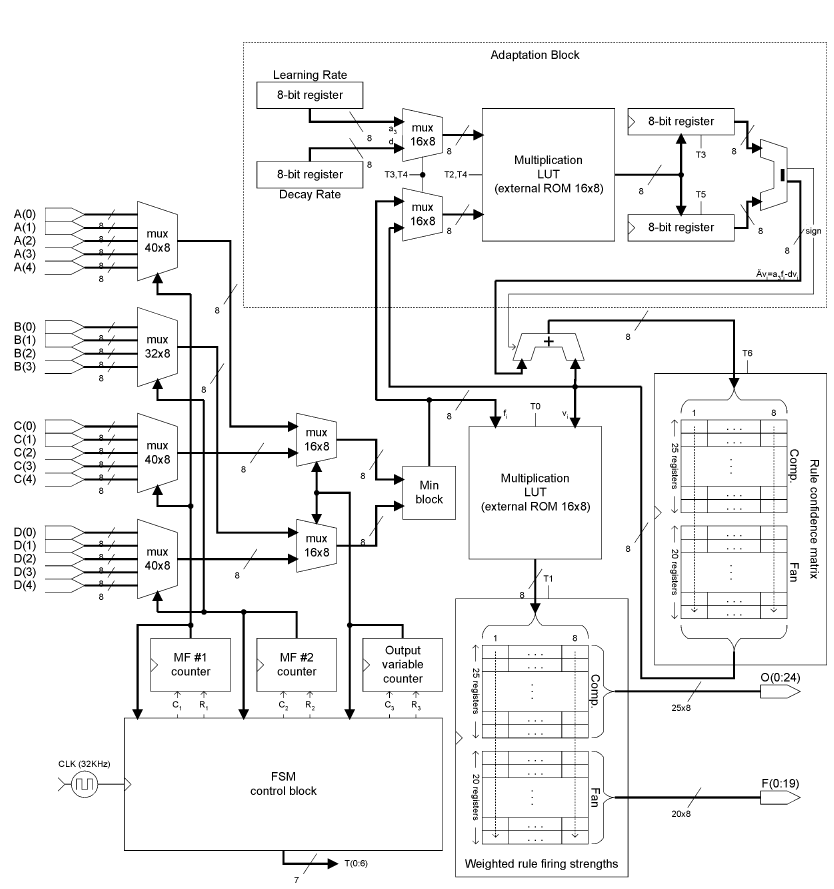
FIGURE 9 Rule base